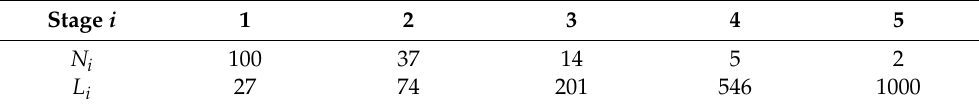
Table 2. Number of critical designs and replications in each stage.